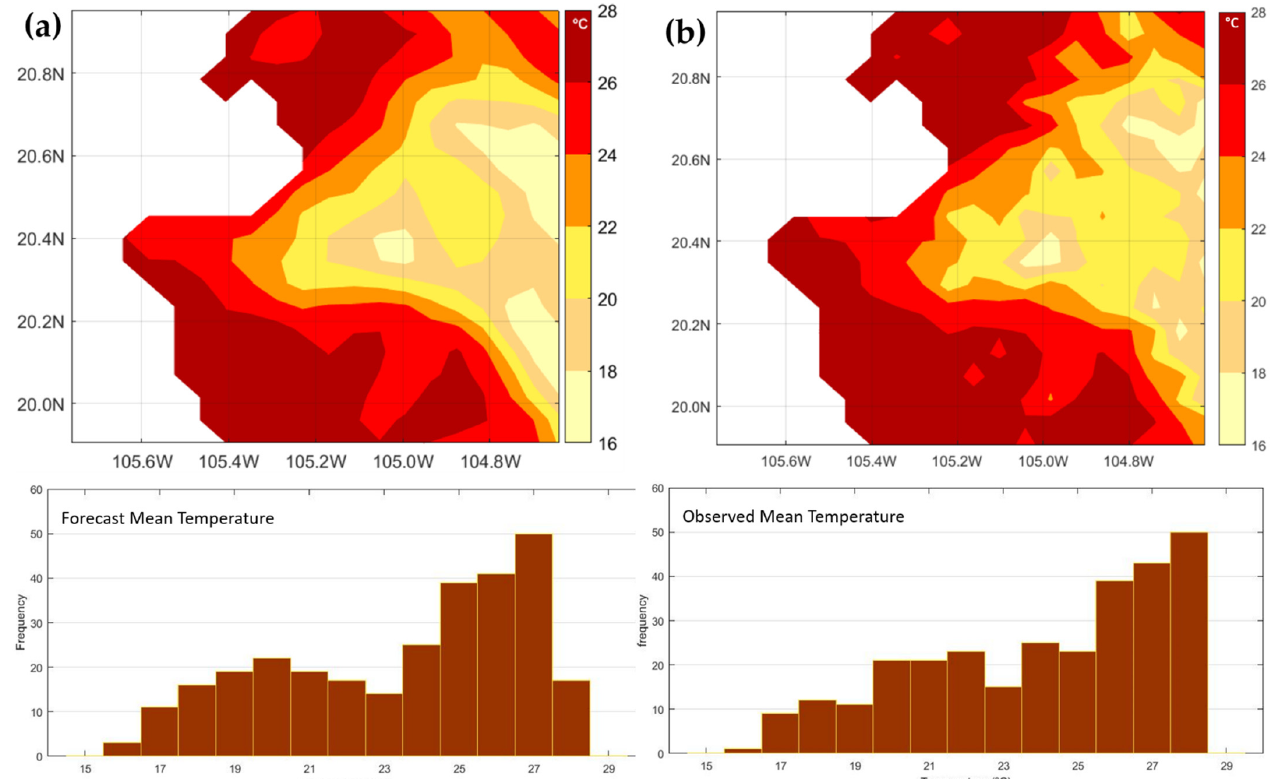
Figure 4. Forecasted and observed mean temperature maps with their respective histograms (10 June–31 October 2010). ( a ) Distribution of forecast mean temperatures; ( b ) distribution of mean temperatures observed.